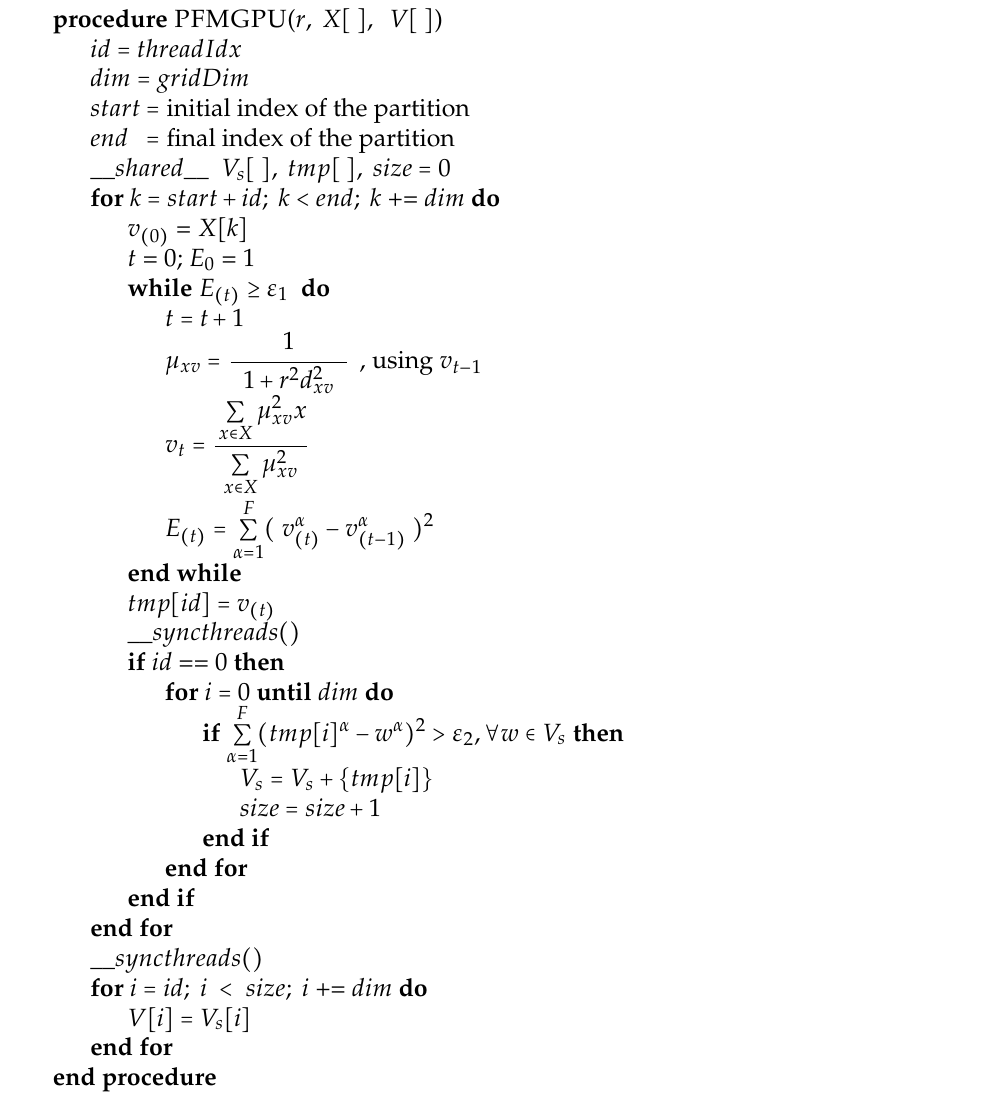
Algorithm 3 FM kernel on